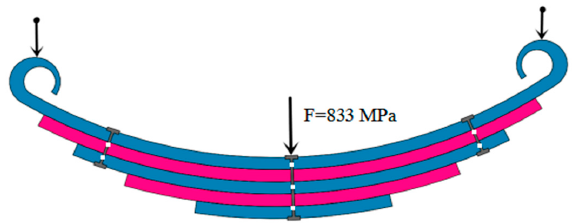
Figure 2. Fatigue tests for automobile plate spring (F = 833 MPa; f = 1 Hz).